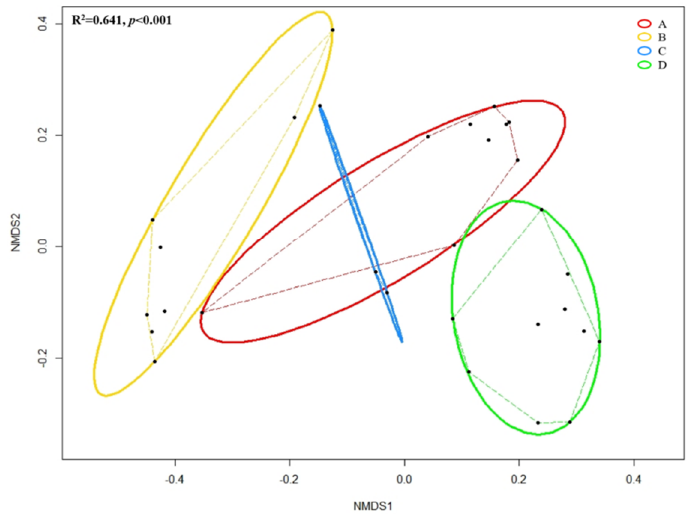
Figure 6. Non-metric multidimensional scaling (NMDS) based on Bray–Cutis distance matrix enclosing all 30 datasets. Black dot represents individual skin microbial community; Solid lines represent ellipses enclosing all points in different groups; Dashed lines represent convex hulls by ordihull function. Significance across groups ( p -value) based on ANOSIM; Group A: Clarksville dairy farm; Group B: Upper Marlboro integrated farm; Group C: Washington DC integrated farm; and, Group D: University of Maryland—College Park campus.